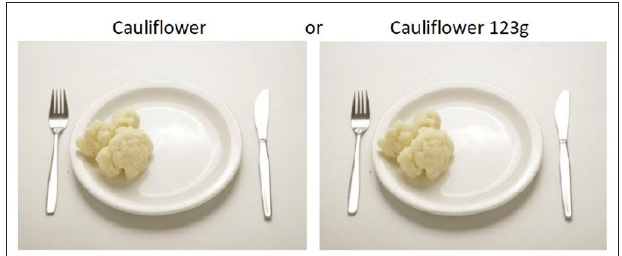
FIGURE 1 | Portion with and without weight